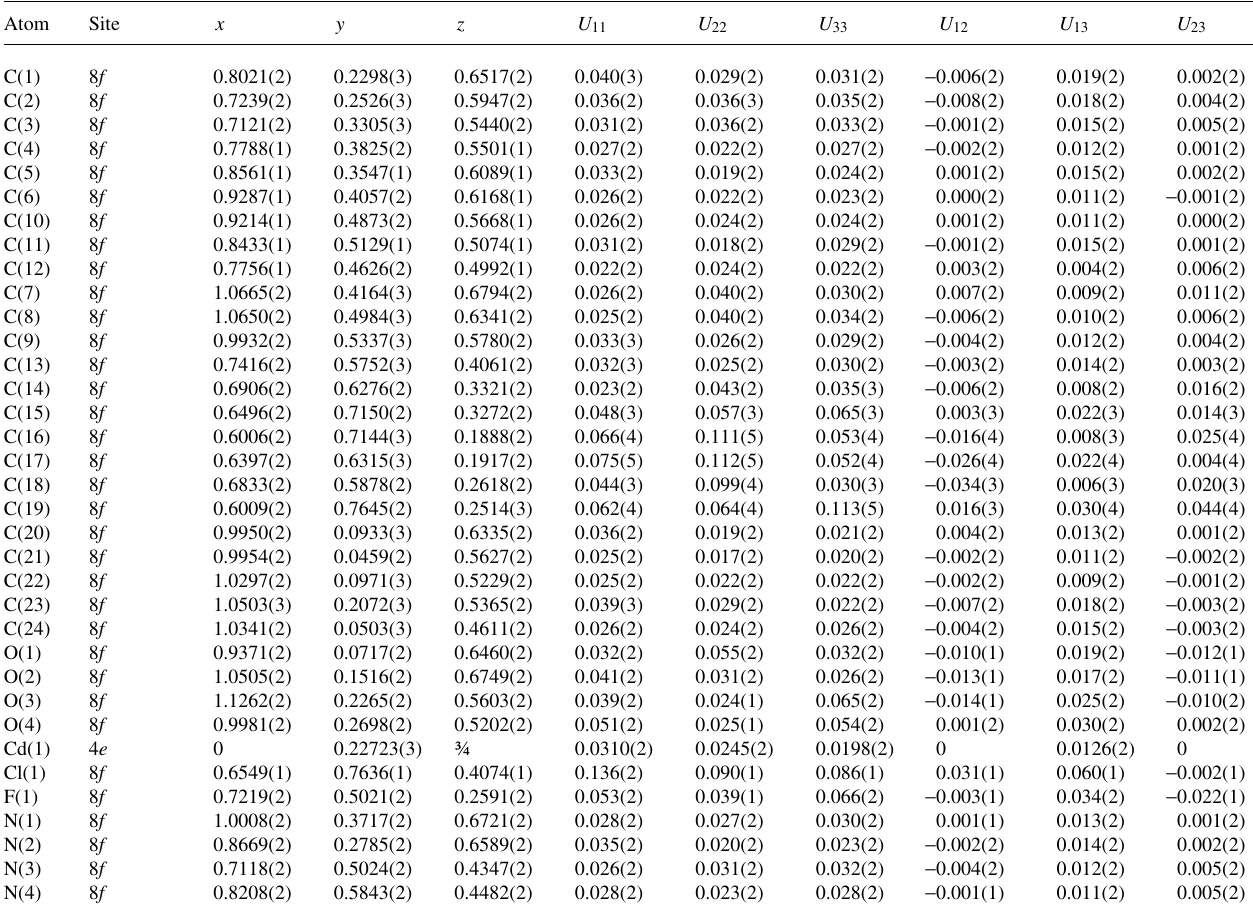
Table 3. Atomic coordinates and displacement parameters (in Å 2 )